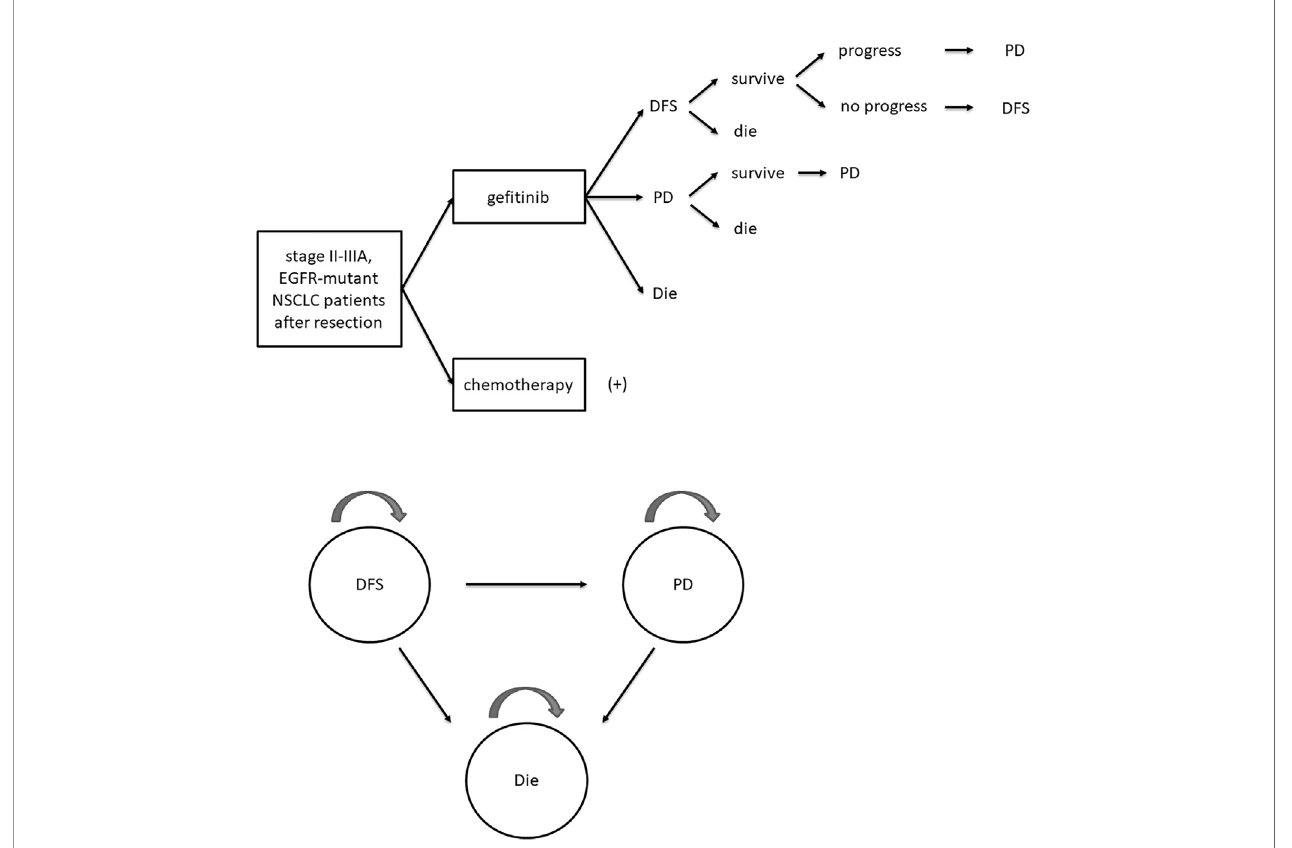
FIGURE 1 | Schematic diagram of Markov model. DFS, disease-free survival; PD, progressive disease; EGFR, epidermal growth factor receptor; NSCLC, non-small-cell lung